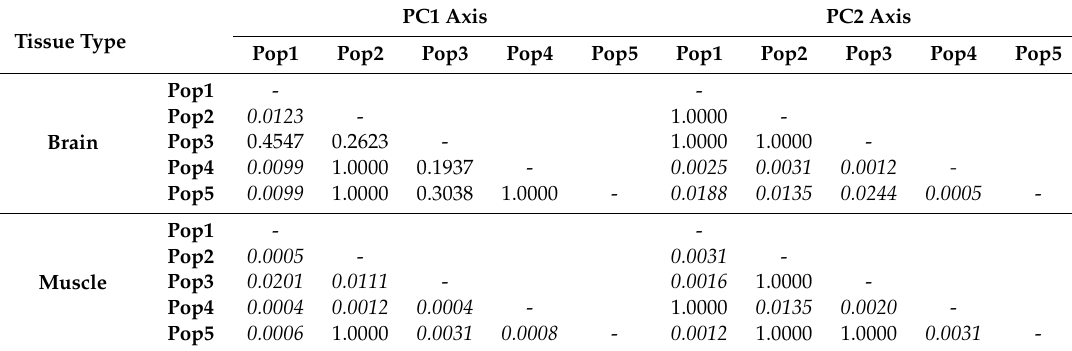
Table 6. Group di ff erentiations of the five surveyed populations based on the results of pairwise KW tests. Significant group di ff erences / p < 0.05 / are italicized.